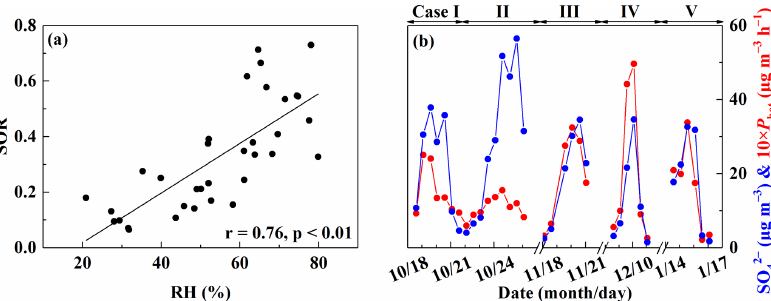
Figure 3. The relationship between relative humidity (RH) and SOR (a) and time series of overall heterogeneous sulfate production ( P het ) along with SO 2 − concentrations (b) . The black line in (a) is the linear least-squares fitting line. 4